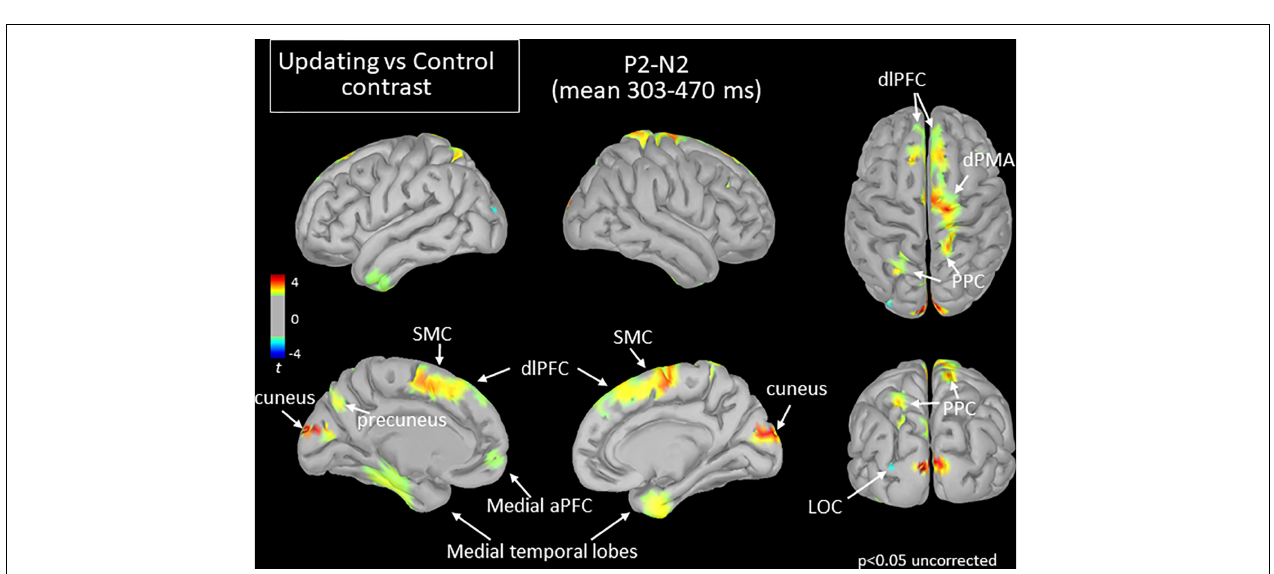
FIGURE 6 | Statistical map (cortex only, p < 0.05 uncorrected) for the Updating vs. Control contrast computed during the N 1 P 2 component of the RotEP. The t -test analysis did not reveal significant effect when correcting for multiple comparisons (FDR correction). aPFC, anterior prefrontal cortex; dlPFC, dorsolateral prefrontal cortex; LOC, lateral occipital cortex; PFC, prefrontal cortex; PPC, posterior parietal cortex; SMC, supplementary motor complex.